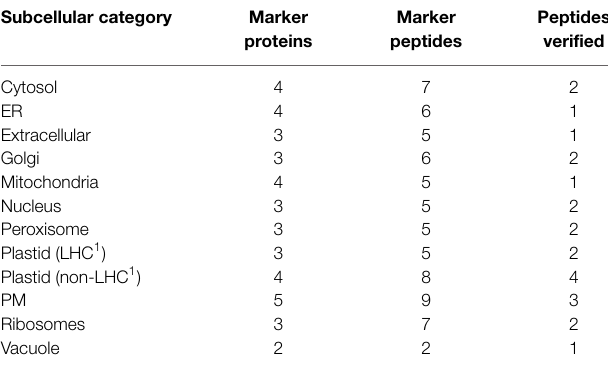
TABLE 1 | Summary of representative marker proteins and peptides used for detection of subcellular compartments by MRM. Subcellular category Marker